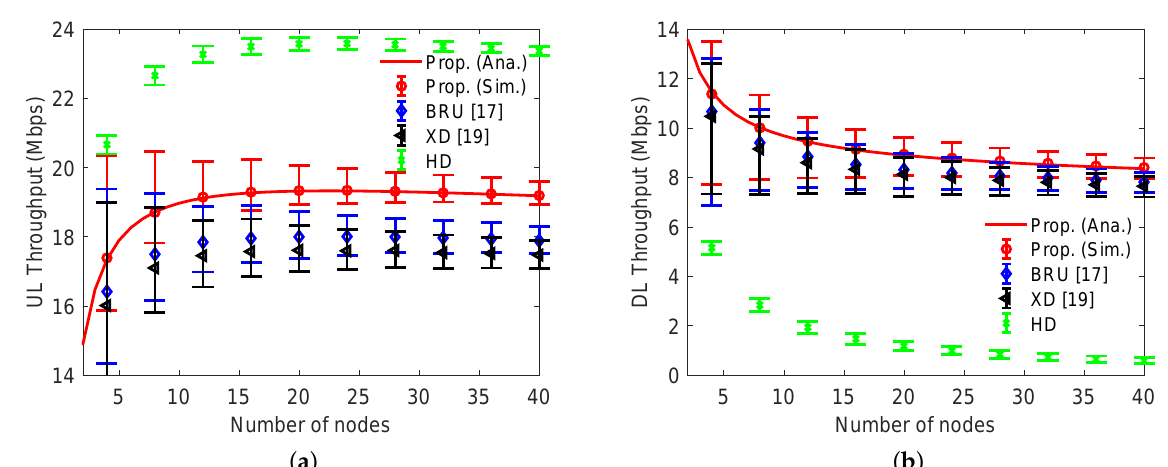
Figure 3. Throughput based on the number of nodes (self-interference cancellation (SIC) = 110 dB) for ( a ) UL and ( b ) DL.